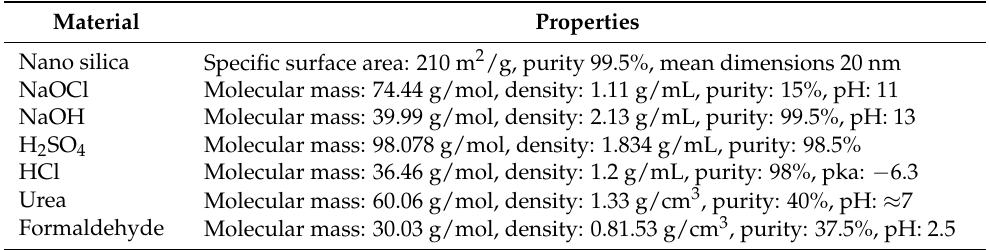
Table 1. Main properties of chemical used materials. Material